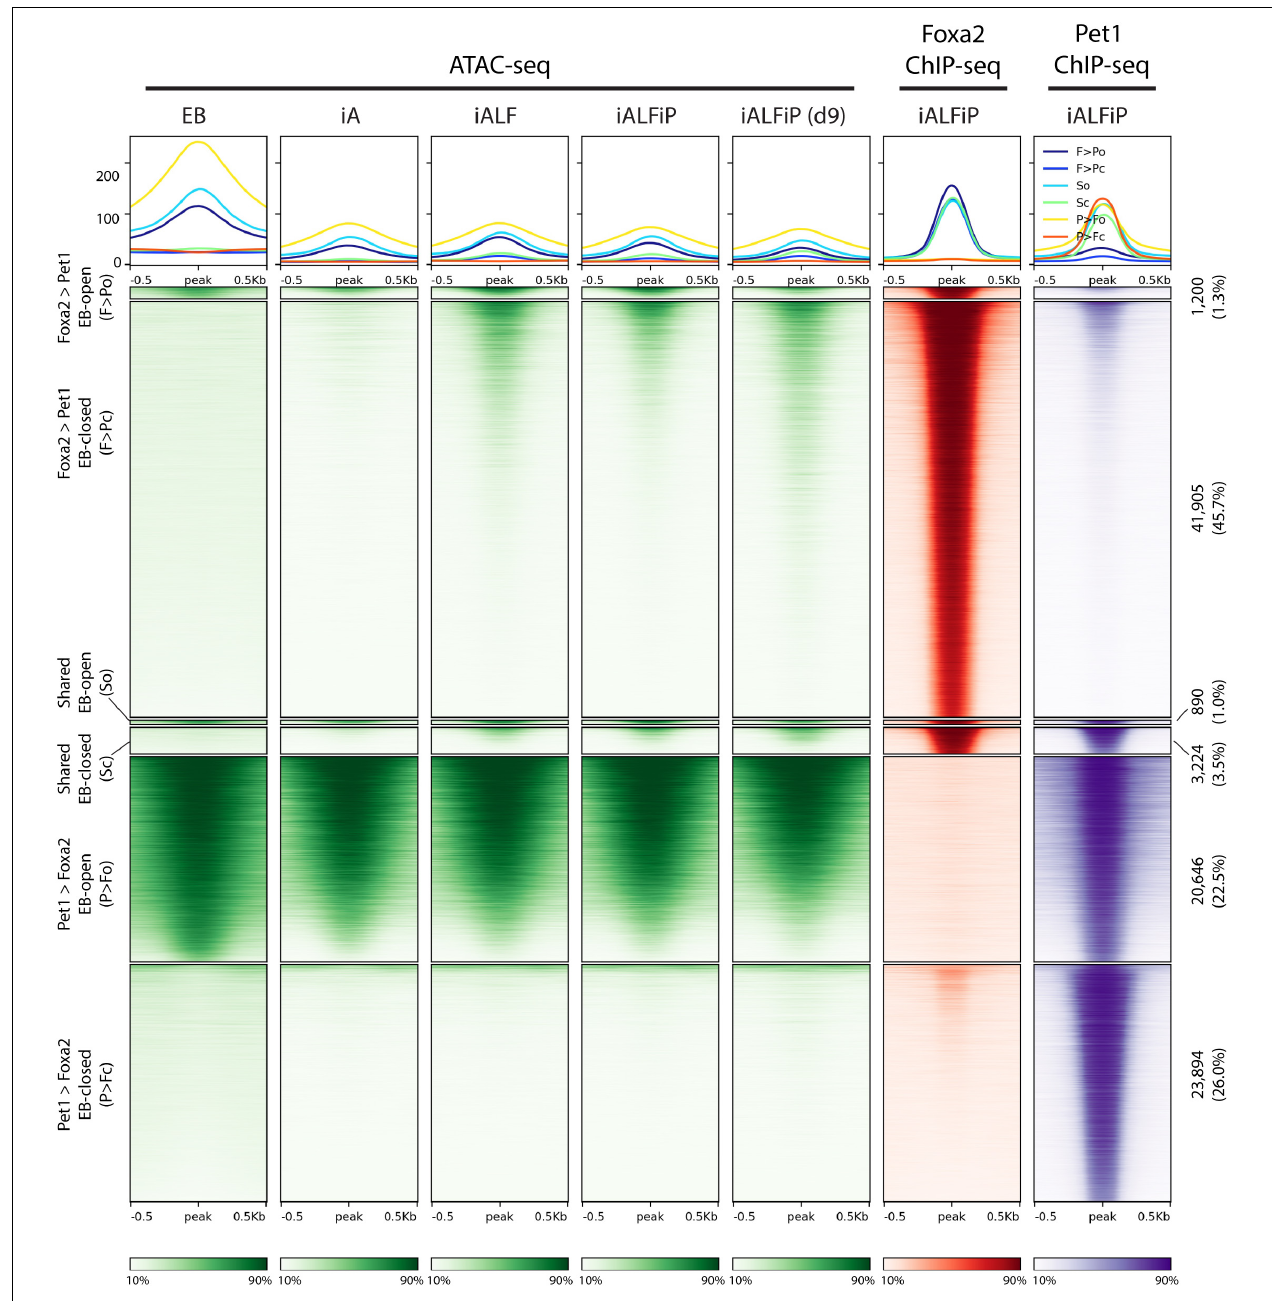
FIGURE 5 | Comparison of ATAC-seq profiles with iALFiP Foxa2 and Pet1 binding categories. ATAC-seq heatmaps plot EB, iA (48 h), iALF (48 h), iALFiP (48 h), and iALFiP (d9) ATAC-seq signals over the Foxa2 and Pet1 binding categories displayed in Figure 4C . Each Foxa2 and Pet1 binding category is first split into two groups according to overlap with ATAC-seq domains in the preexisting EB cell state. Thus, six categories of sites are plotted. Panels above heatmaps display average ATAC-seq or ChIP-seq signals in each of the six categories. The color scaling in all heatmaps vary between the read counts observed in the 10th and 90th percentiles of